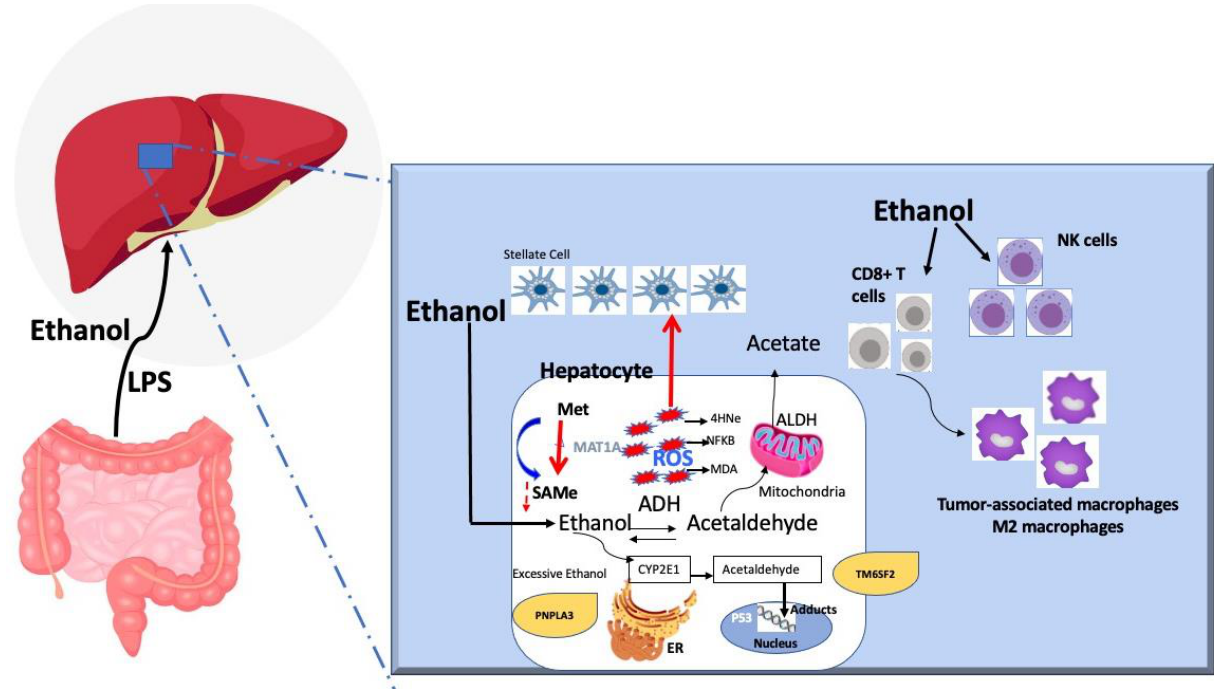
Figure 1. Pathways involved in alcohol-mediated liver carcinogenesis. Ethanol is first metabolized by alcohol dehydrogenase (ADH) into acetaldehyde which enters the mitochondria and becomes oxidized via acetaldehyde dehydrogenase (ALDH). Upon excessive alcohol intake, the endoplasmic reticulum or peroxisomes me-